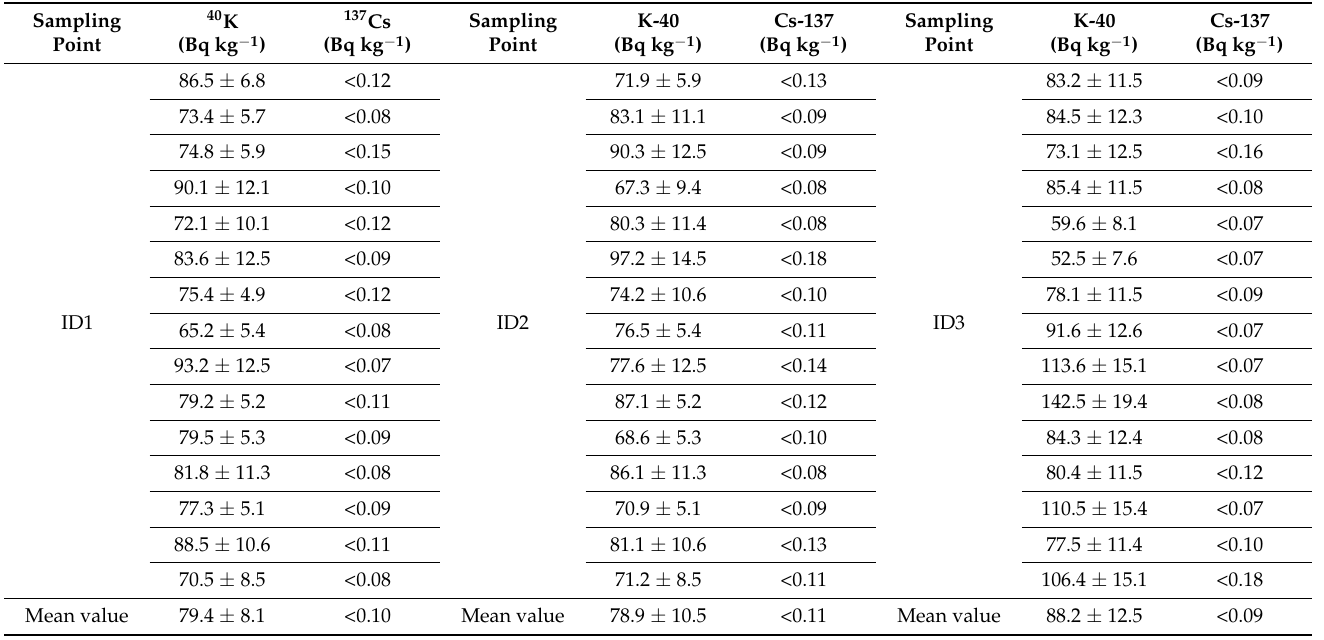
Table 2. The specific activity of 40 K and 137 Cs for the analyzed bovine meat